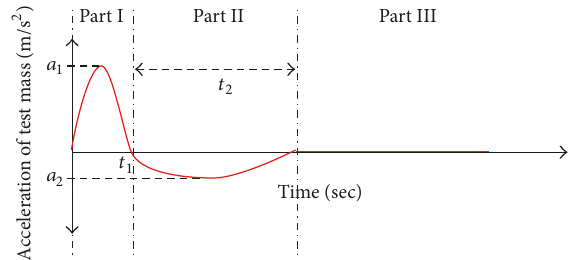
Figure 1: Shape of dual shock-wave profile in